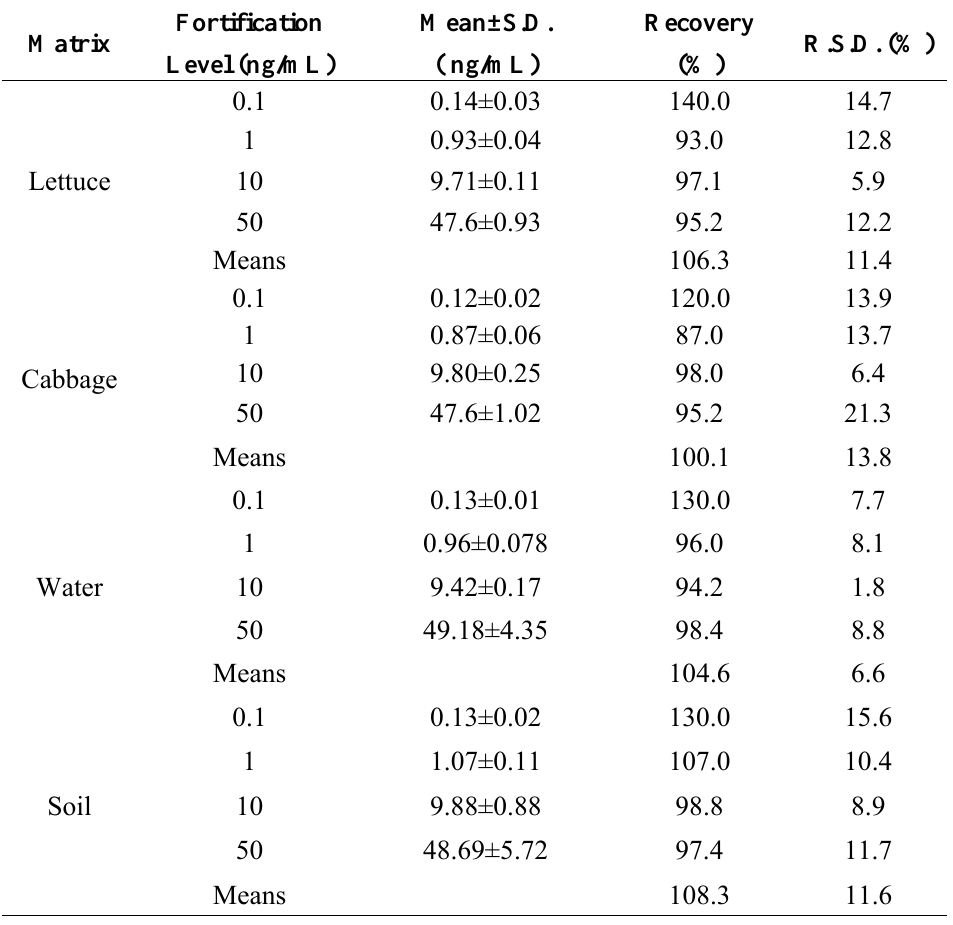
Table 2 . Analyses of carbofuran in water, soil, lettuce and cabbage samples by ELISA (n = 3).